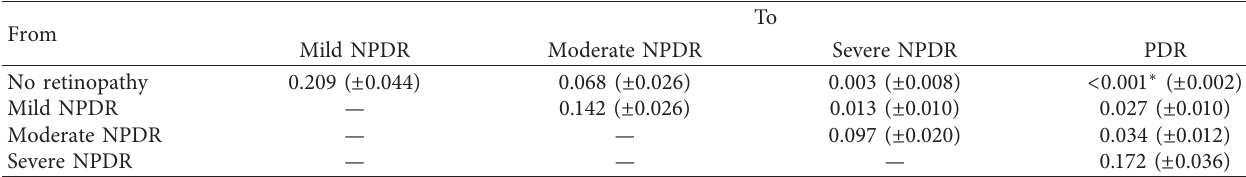
Table 7: Estimated average transition rate matrix over time ( ± SD) for a non-Hispanic individual, assuming that other risk factors take their mean values.